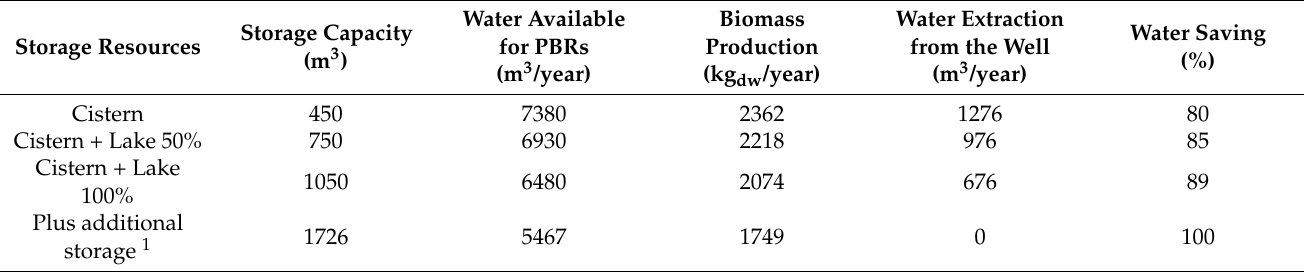
Table 6. Simulation of PBR plant capacity and productivity, and consumption of underground water, depending on the reservoir